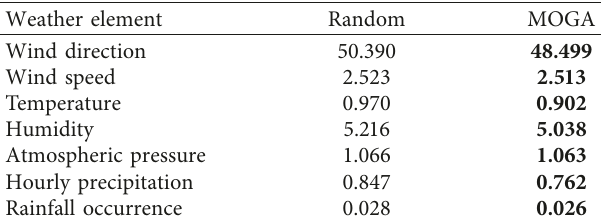
Table 9: Comparison of SVR estimation accuracy with neighboring stations selected randomly or by MOGA.